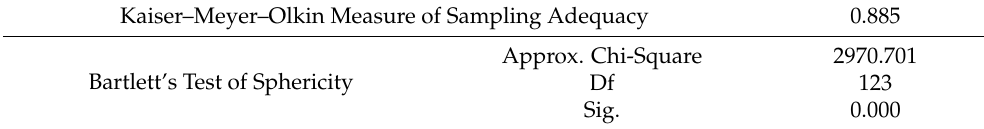
Table 3. KMO and Bartlett’s Test.